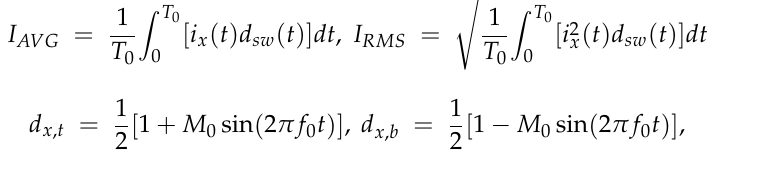
Figure 5. Electrical circuit of snubber two-level (S2L) inverter: (1) DC-bus capacitor in orange, (2) recovery circuit in green, (3) three-phase inverter circuit in blue, and (4) snubber circuit in